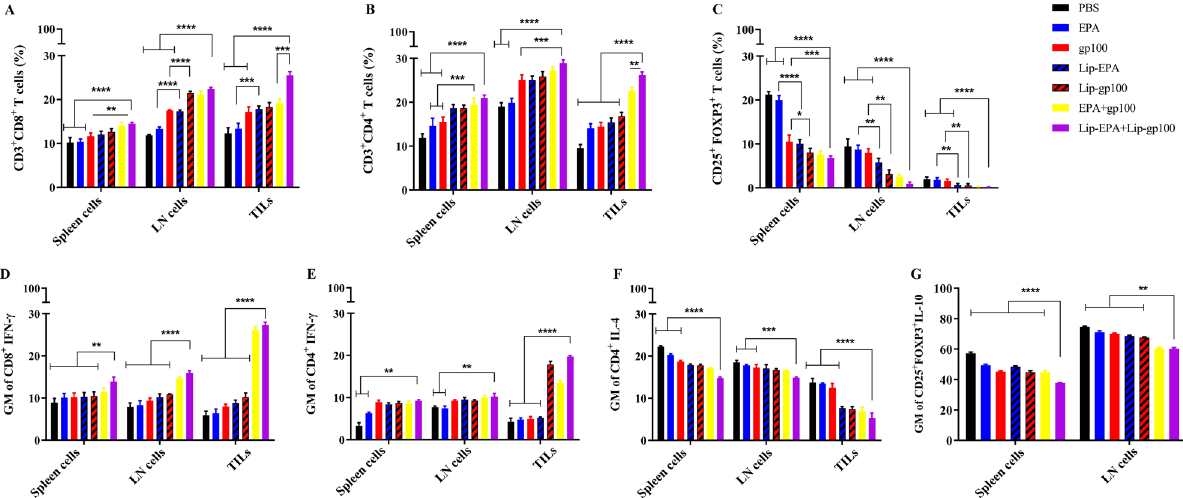
Figure 4. The Flow cytometric analysis of lymphocyte populations in spleen, lymph node, and the tumor site. ( A ) The frequency of CD3 + CD8 + T cells, ( B ) CD3 + CD4 + T cells and ( C ) CD25 + FOXP3 + Treg cells in different tissues from mice received different treatments. The geometric mean of IFN-γ- producing splenic/ lymph node/ intra tumoral ( D ) CD3 + CD8 + T cells, ( E ) CD3 + CD4 + T cells. ( F ) The geometric mean of IL-4-producing splenic/lymph node/intra tumoral CD3 + CD4 + T cells and ( G ) The geometric mean of IL-10- producing splenic/lymph node CD4 + CD25 + FOXP3 + Treg cells. Data are represented as mean ± standard deviation (n = 3). *p < 0.05, **p < 0.01, ***p < 0.001, **** p < 0.0001. LN lymph nodes, TILs tumor infiltrated